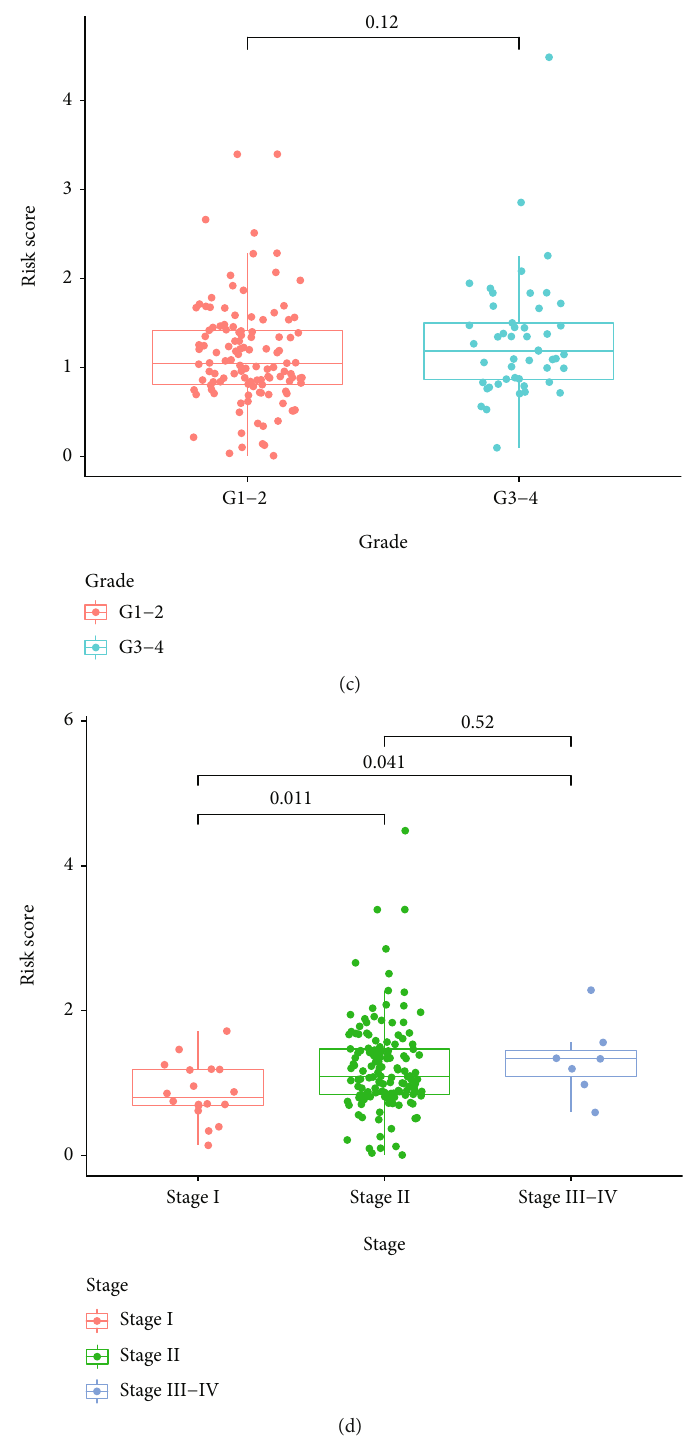
Figure 6: The association between risk score and (a) age, (b) gender, (c) grade, and (d)